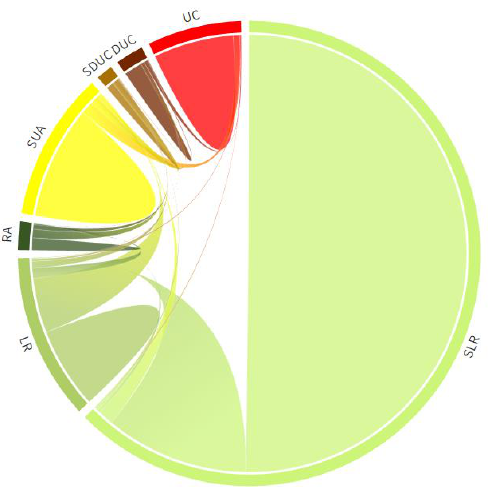
Figure 5. Chord diagram of urban-rural types in Guangdong Province from 2005 to 2020.